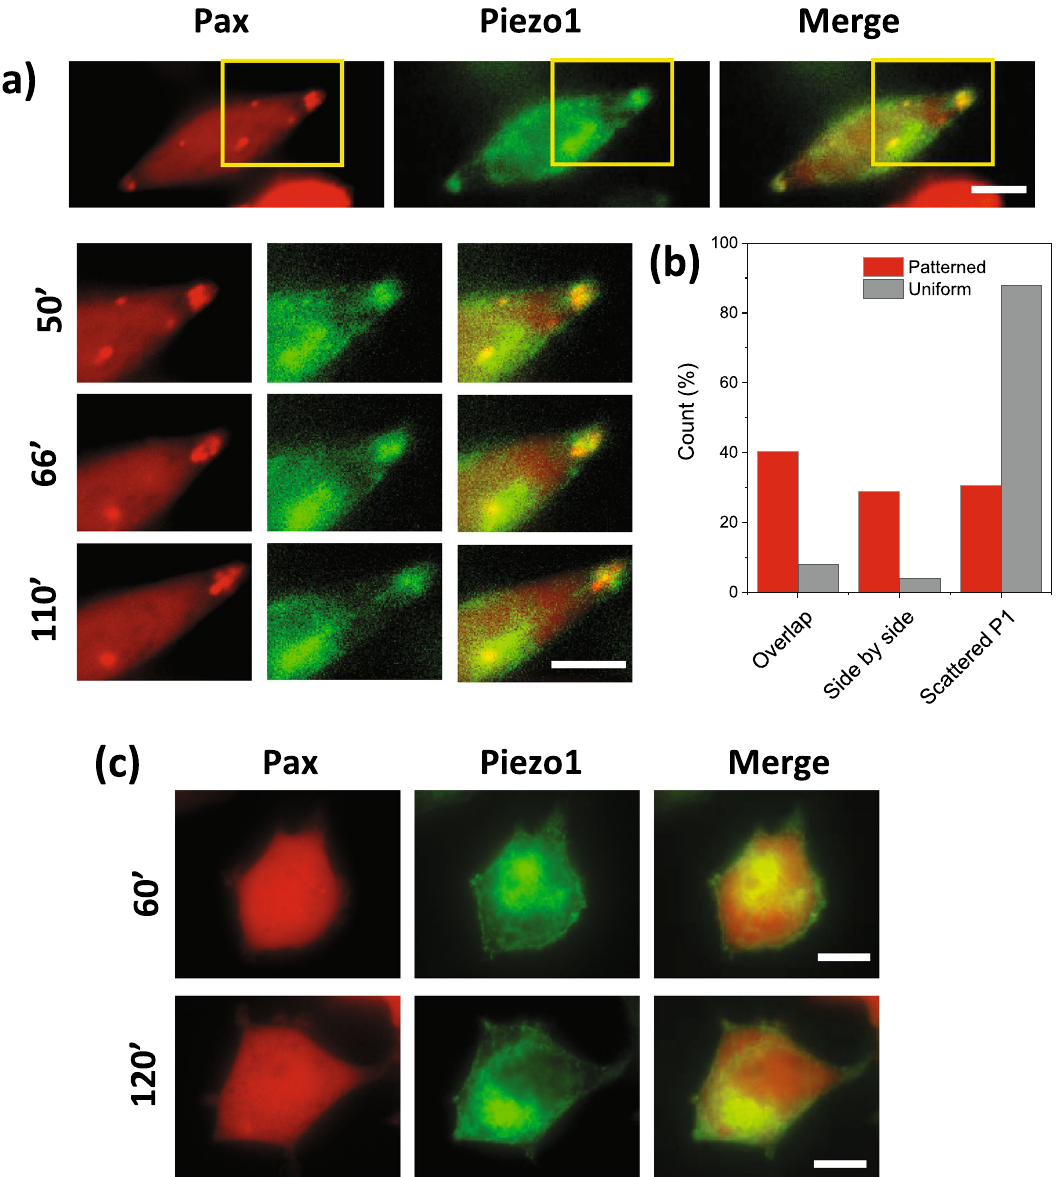
Figure 4. Piezo1 plaques correlate with FAs at the cell extrusion edges on the pattern. (a) Images of a typical HEK-hP1 cell (Piezo1, green) co-expressing mApple-paxillin (red); the zoomed view shows the co-localization between Piezo1 plaques and FAs at the extrusion edge at various times during cell elongation. (b) Statistical data shows that the two proteins collocated in most elongated cells, but side by side in some cells (n = 62 for patterned cells, n = 25 for control cells). (c) Images of paxillin and Piezo1 in a control cell (without pattern) show that there are no mature FAs present at the cell edges. Scale bars represent 10 non-stretching cells. In migrating cells, the Piezo1 distribution is polarized and mainly located at the leading edge. The redistribution of Piezo1 proteins was only observed in the cells on narrow stripes that imposed a mean tension gradient on the cell. On uniform substrates, Piezo1 is mostly located in the middle of the cell. A previous study by the Rosenblatt group shows that Piezo1 overexpression occurred at the cell edges of sparse regions where the cell membrane was expanded 12 . The redistribution of Piezo1 proteins is sensitive to the stresses in cells such as cytoskeletal stress and correlated membrane tension. It is widely recognized that cells use transmembrane integrins at focal adhesions to translate extracellular matrix (ECM) mechanical cues to the cytoskeleton to facilitate cell remodeling 1–3 . Our study shows that Piezo1 plaques co-localize with mature FAs at cell expansions. Although Piezo1 proteins exist in the thin tail-like fea- tures, no mature FAs were observed in those domains. Without the patterns, neither distinct Piezo1 plaques nor mature FAs were observed along the cell periphery (Fig. 4). A recent study has shown that Piezo1 is recruited